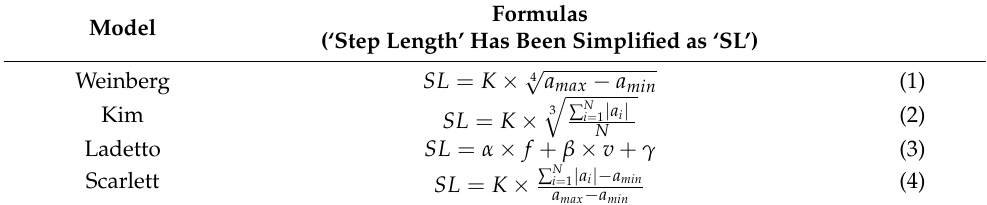
Table 2. Empirical models proposed for stride length estimation.